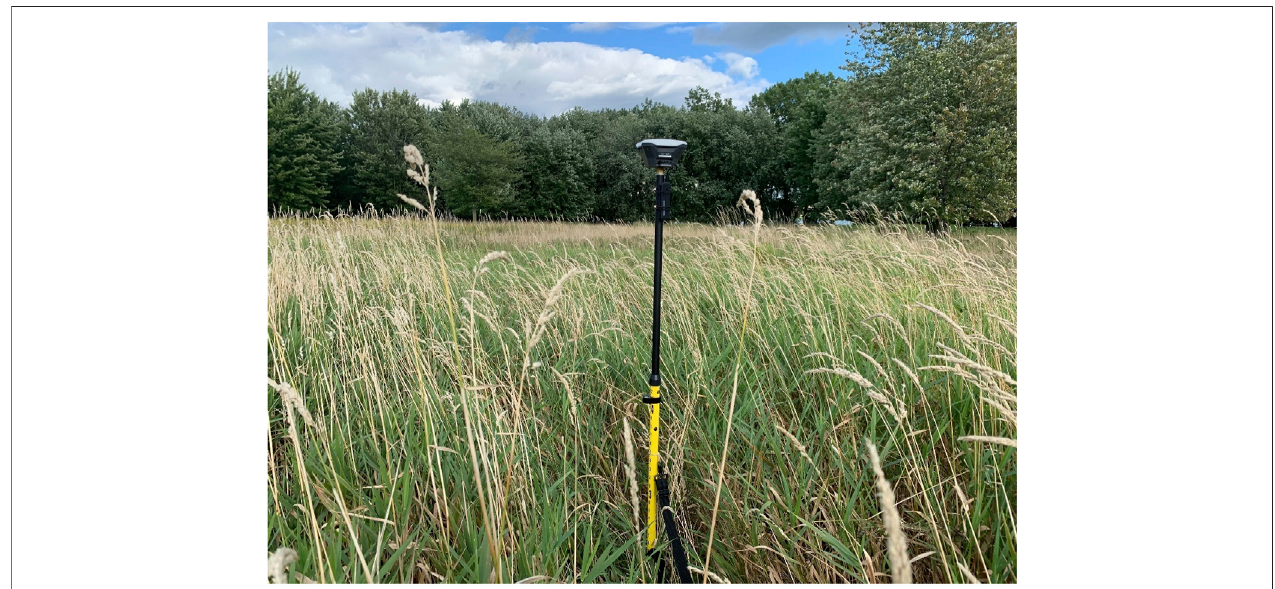
FIGURE14| Aphotoofalargeexpanseof Phalarisarundinacea takenwithinÎles-de-BouchervilleNationalPark.The2 mtallmonopodwiththeEMLIDReachRS+ GNSS receiver is present in the photograph to provide context of scale.